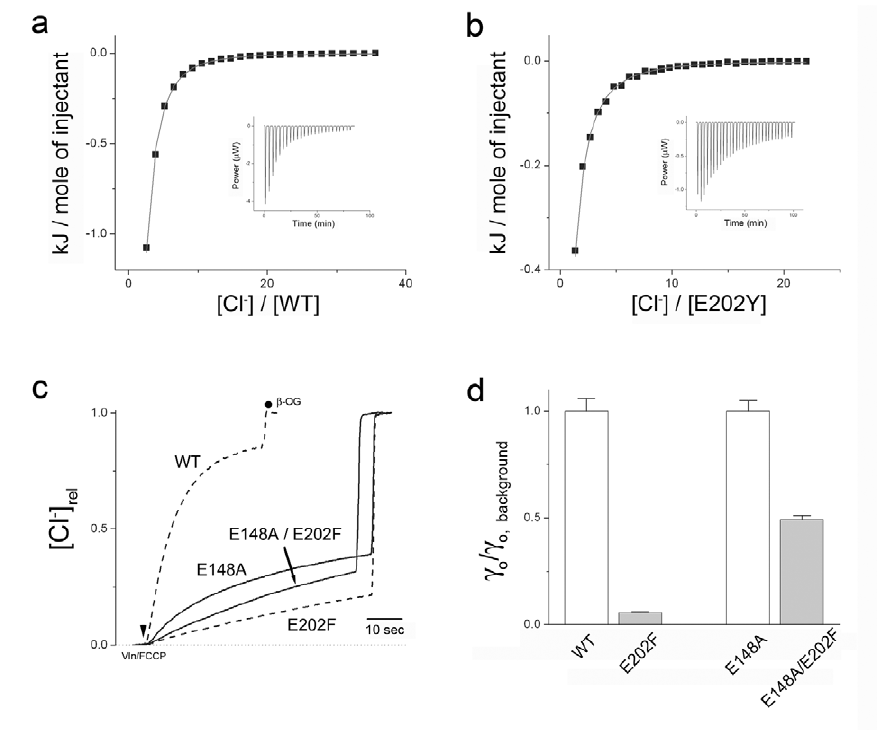
Figure 3. Effect of E202 substitutions on Cl 2 pathway. (a, b) Equilibrium Cl 2 binding isotherms determined by ITC for wild type or E202Y, respectively. Solid curves represent single-site binding curves with K D =0.74 and 1.6 mM, respectively (Table S3). (c) Effect of E202F mutation on Cl 2 efflux traces in fully H + -uncoupled transporter, E148A. For comparison, dashed lines reprise the effect of E202F on the H + -coupled wild type. (d) Summary of E202F effect on Cl 2 efflux rates c o on coupled (WT) and uncoupled (E148A) backgrounds. Rates are normalized to the background value for comparison.